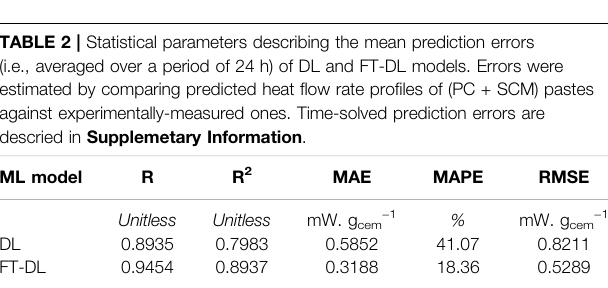
Table 1 . The SCMs comprise permutations-and-combinations of quartz (QZ); limestone (LS); metakaolin (MK); and silica fume (SF). Other details of this database are described in Supplementary Section S2.0 . The parent database was split into training and testing databases. The training database consisted of 13,416 data-records from 559 (PC + SCM) pastes; and the testing database consisted of 960 data-records from 40 (PC + SCM) pastes. The training database was used for training the FT-DL model (and the DL model for comparison), and optimizing the models ’ hyperparameters. The testing database models against experimental measurements. Both databases